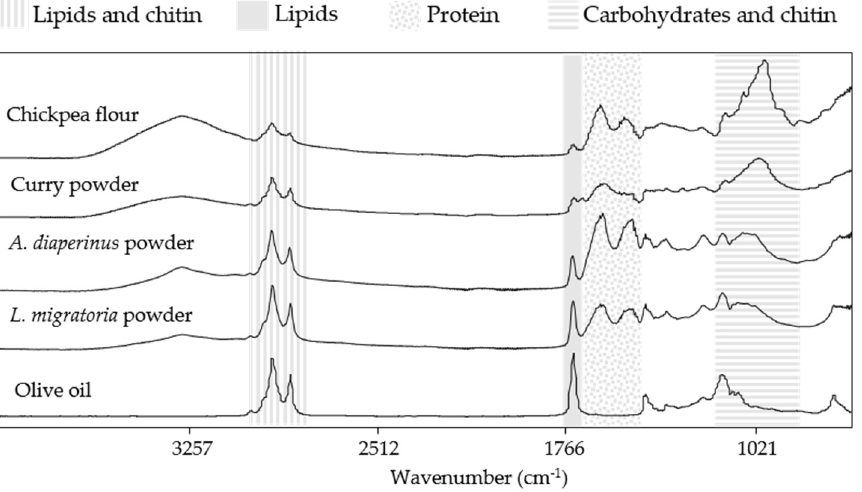
Figure 2. Raw mid-infrared spectra (4000 to 800 cm − 1 ) from the ingredients used to prepare the doughs and the snacks.